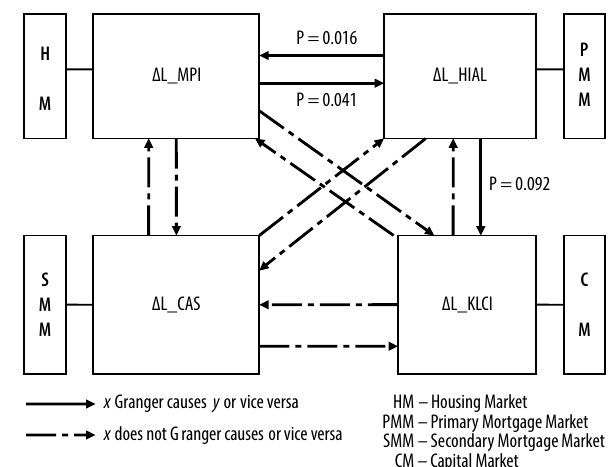
Fig. 3. Causality for lead-lag